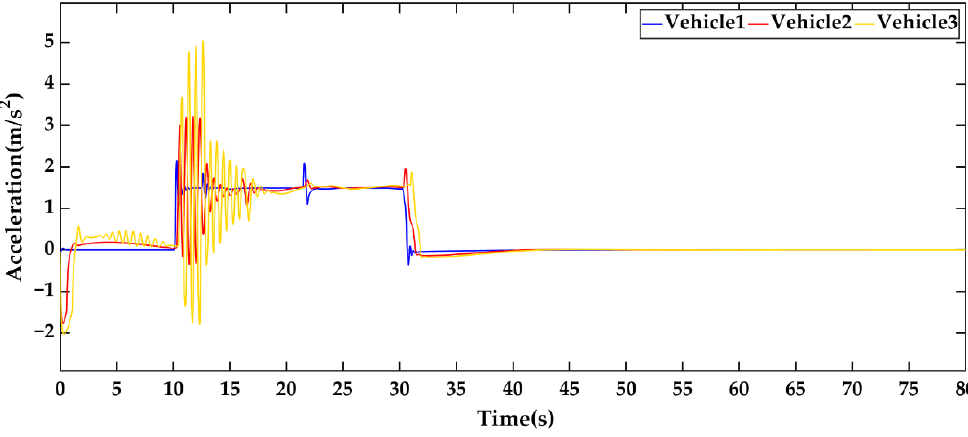
Figure 11. The accelerations of the following vehicle under the standard MPC strategy in Scenario 1.